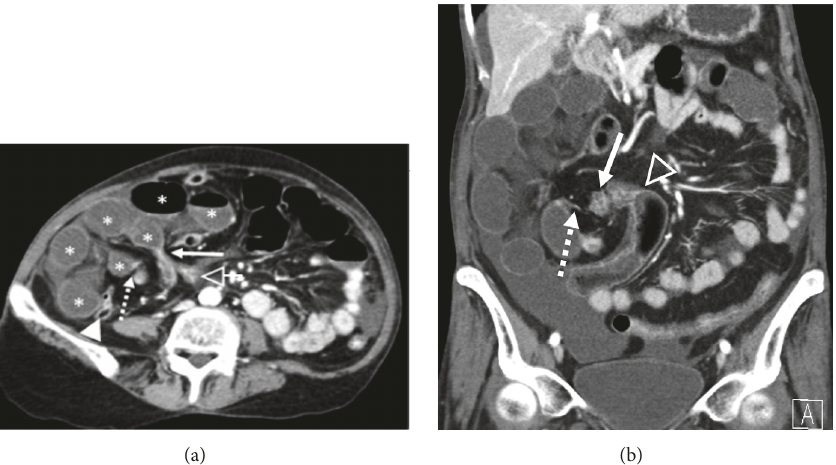
Figure 1: Contrast enhanced CT of the abdomen and pelvis demonstrating closed loop obstruction in the right lower quadrant. (a) Axial CECT demonstrating a proximal transition point within the proximal ileum (dashed arrow) and a nearby distal transition point within the distal ileum (solid arrow). The dilated bowel loops ( ∗ ) are anterolateral to the cecum (open arrowhead) and anterior to the ascending colon (closed arrowhead). (b) Coronal CECT image demonstrating multiple dilated small bowel loops confined to the right abdomen. Note the diminished enhancement of the dilated small bowel loops.